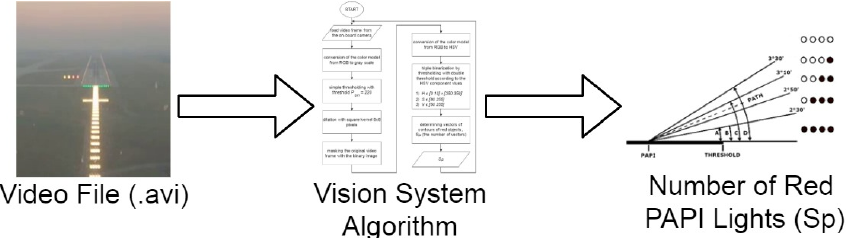
Figure 15. The sequence of tests applied to verify the kernel functions of the developed system.